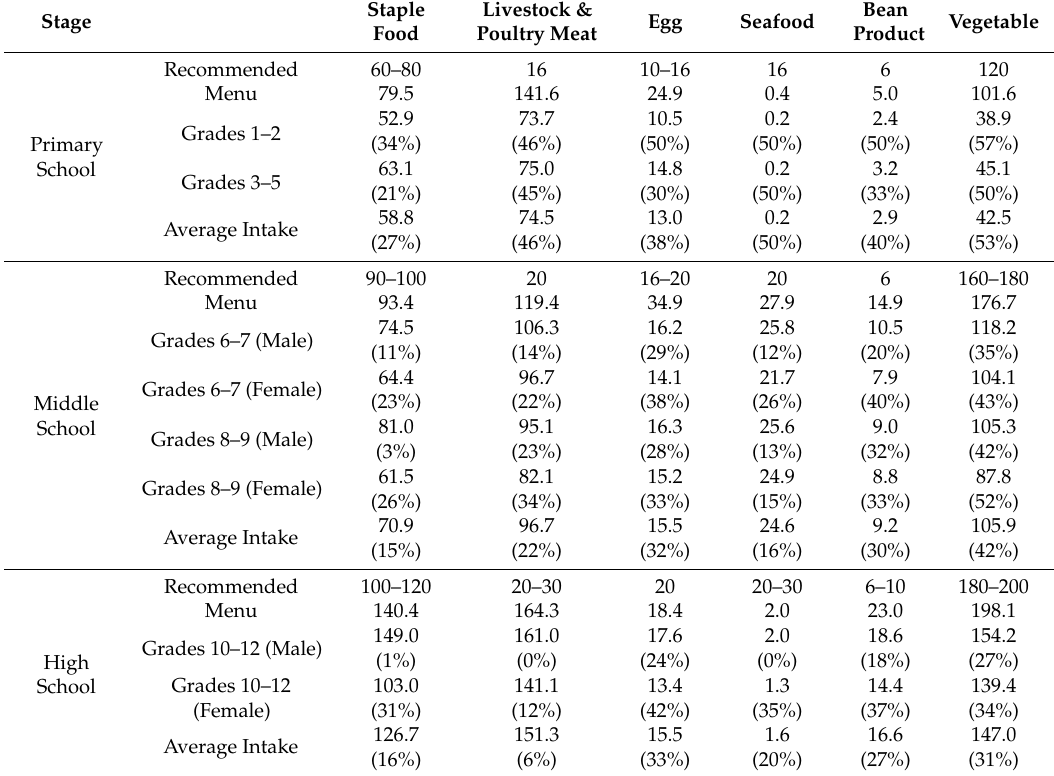
Table 3. Actual food intake and plate waste percentage in seven schools among different age groups and sexes/g